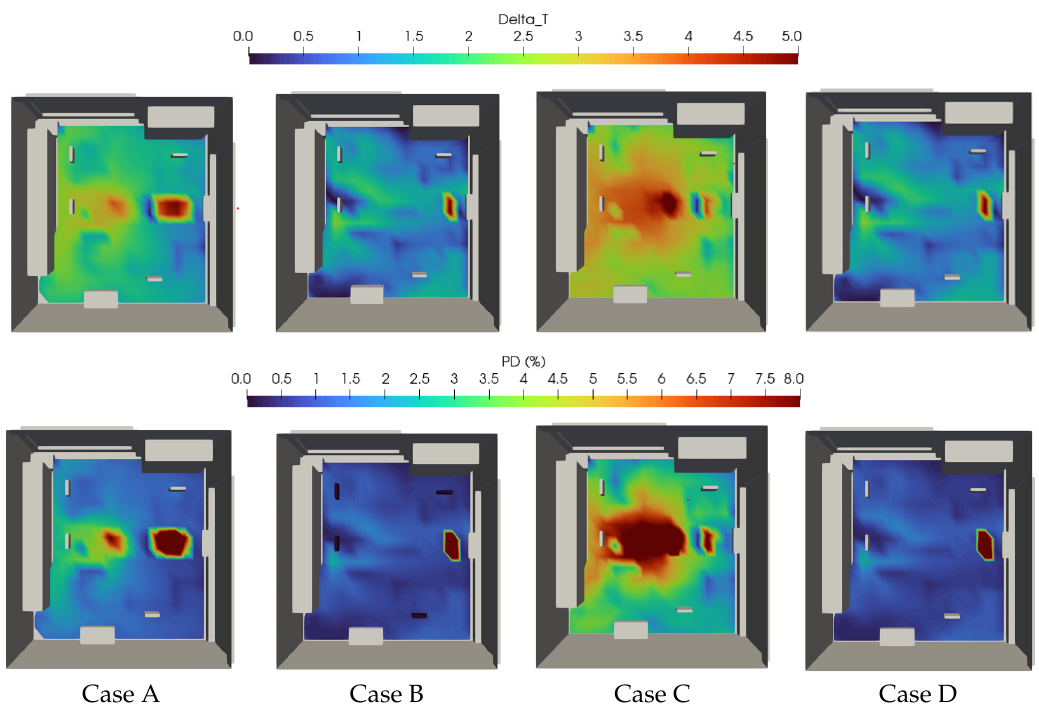
Figure 9. Summer cooling condition. Vertical air temperature gradients (top subfigures) and relative percentage of dissatisfied (bottom subfigures) obtained for low input air velocity and no solar load (Case A), high input air velocity and no solar load (Case B), low input air velocity and solar load (Case C), high input air velocity and solar load (Case